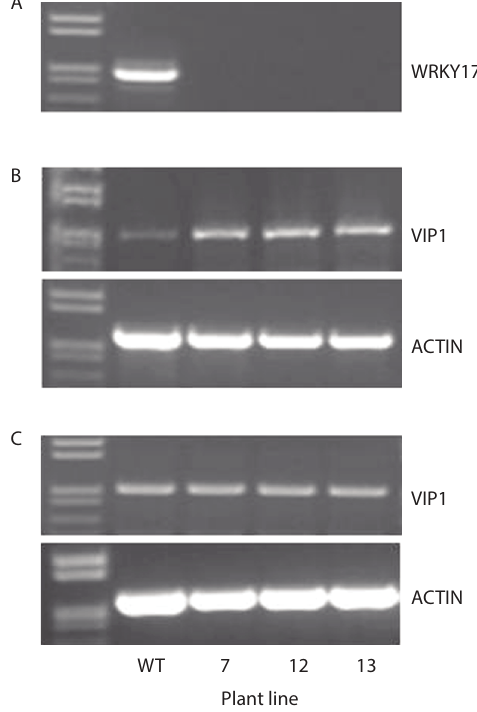
Figure 1. RT-PCR analysis of ACTIN2, WRKY17 and VIP1 gene expression in wild-type and wrky17 mutant Arabidopsis plants . ( A ) WRKY17 expression in whole plants. ( B , C ) VIP1 expression in roots and shoots, respectively. WT, wild-type plants; 7, 12, and 13 are the three different lines of the homozygous wrky17-1